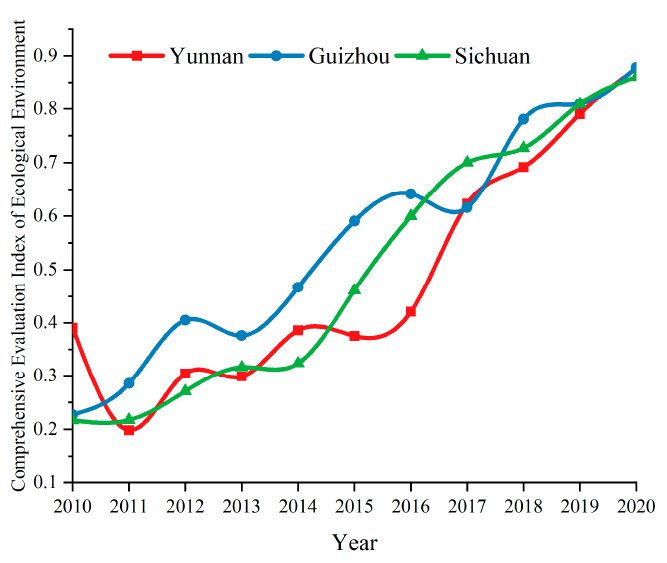
Figure 9. Temporal changes of the ecological environment development level.